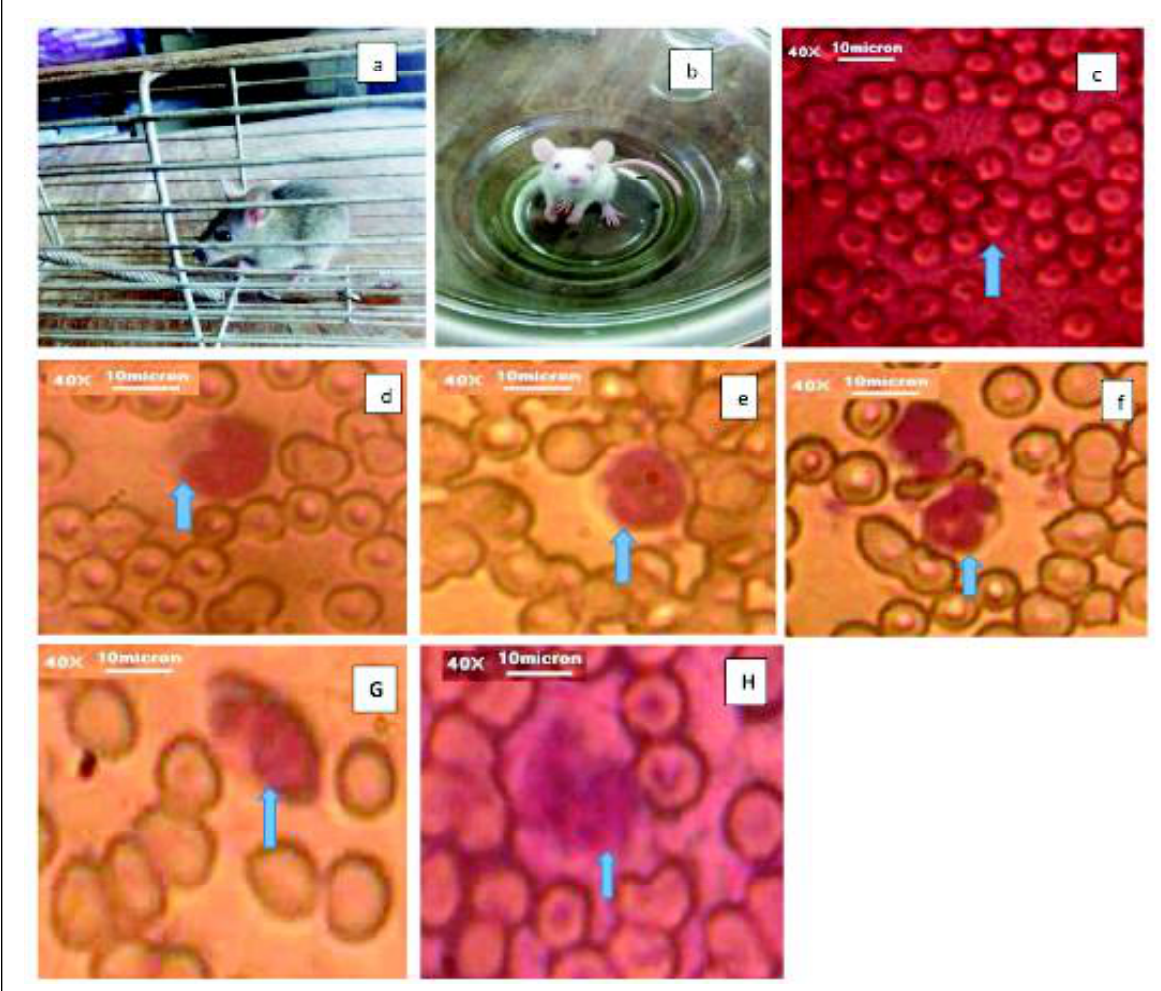
Figure 1: (a) Rattus rattus , (b) Rattus norvegicus , (c) Erythrocyte, (d) Monocyte, (e) Lymphocyte, (f)